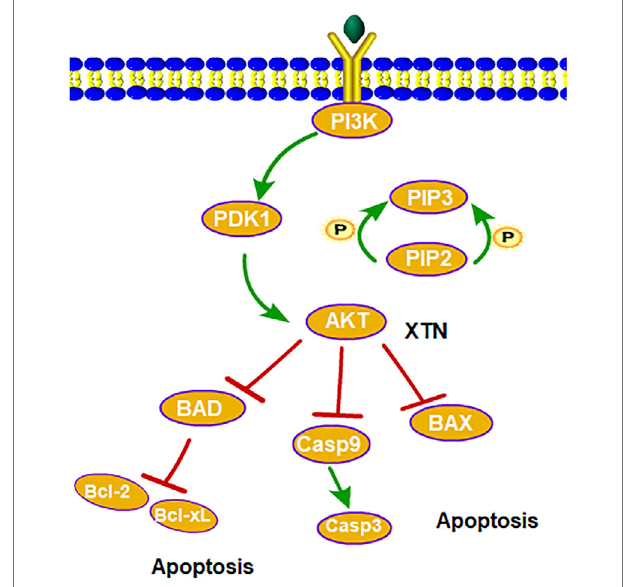
FIGURE 8 | Illustration of the biological process PI3K-Akt pathway caused by candidate